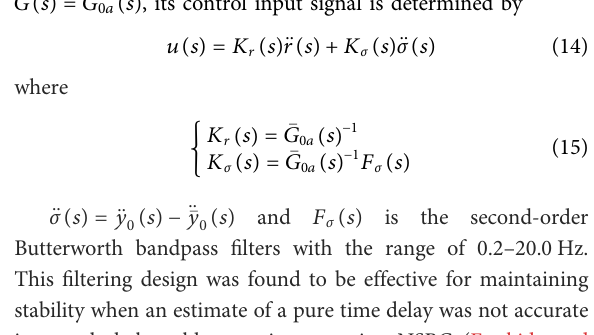
FIGURE 7 JMA Kobe